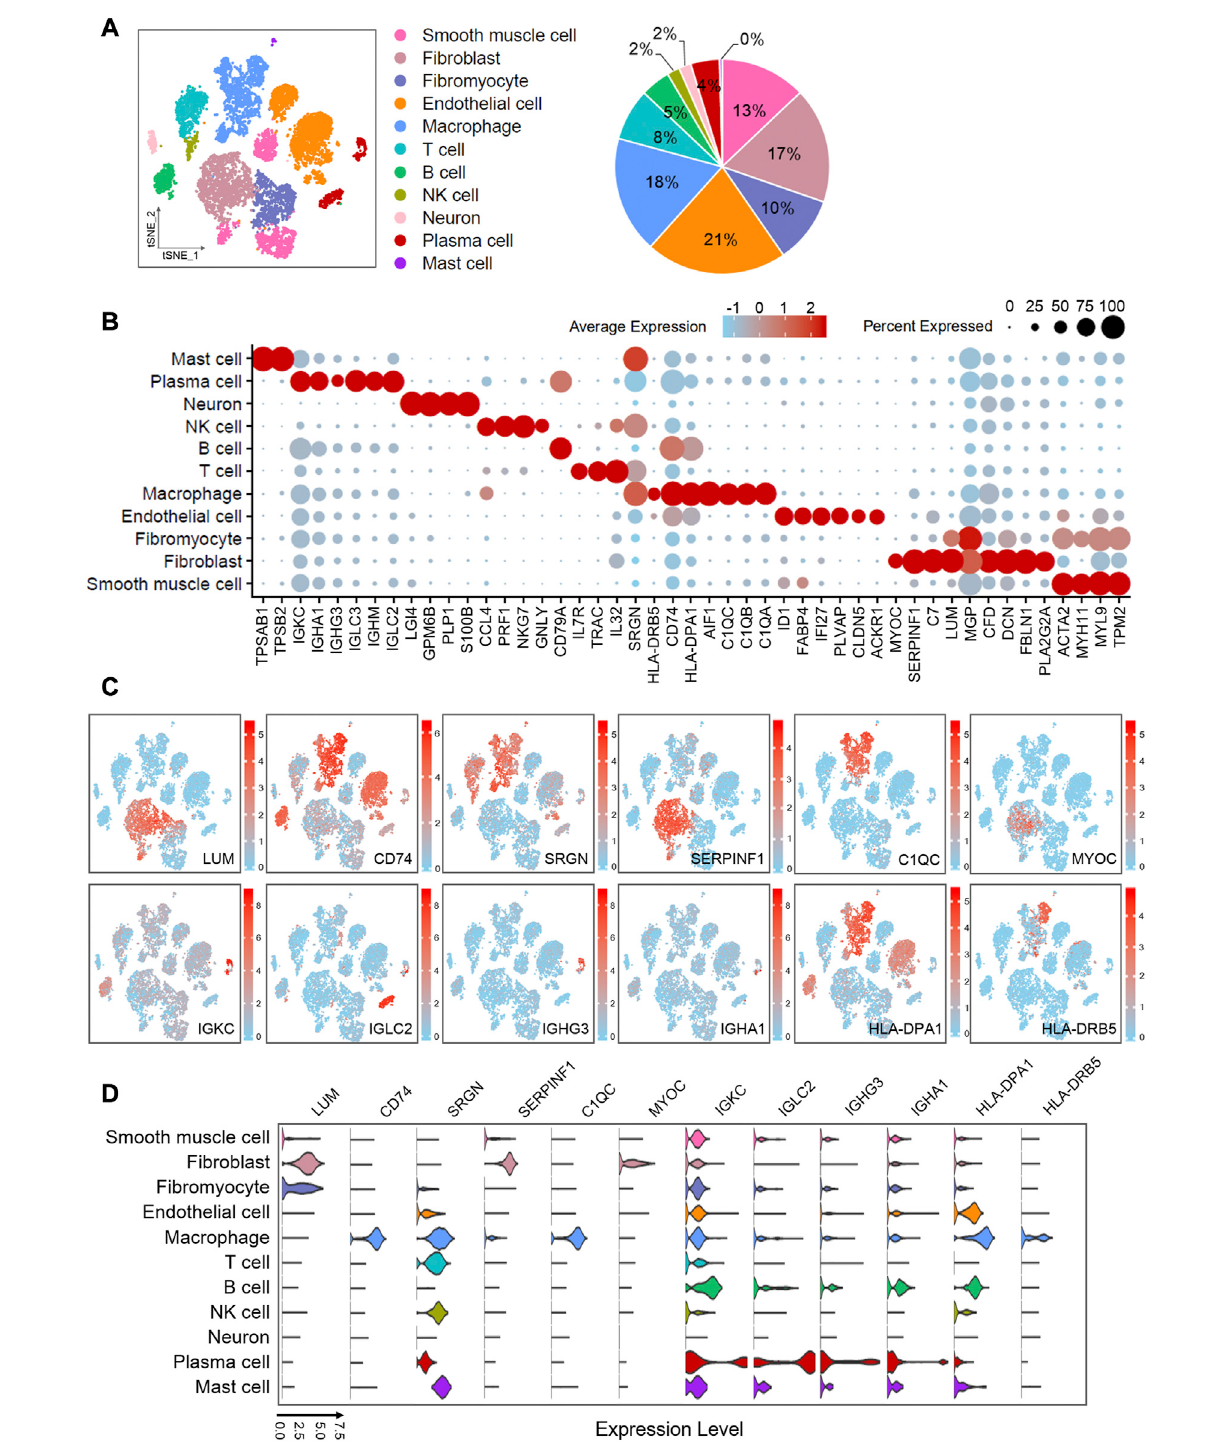
FIGURE 2 Single-cellatlasofhumanatheroscleroticcoronaryarteries. (A) t-SNEplotsshowingclustersof11,754cellsfromeighthumanatheroscleroticartery samples. Pie chart showing the proportions of cell types. (B) Dot plots showing z-score scaled average expression levels of top differentially expressed genes in each cell type. Differentially expressed genes are identi fi ed fromWilcoxon Rank Sum test (adj.p < 0.05). (C) t-SNE visualization of the expression ofgenes. (D) Violinplotsshowingloge(TPM+1)expressionlevelsofgenes.Alloftheexpressionlevelsaremeasuredwiththesamescale.Theanalysis data comes from GSE131778 (GSM3819856, GSM3819857, GSM3819858, GSM3819859, GSM3819860, GSM3819861, GSM3819862,